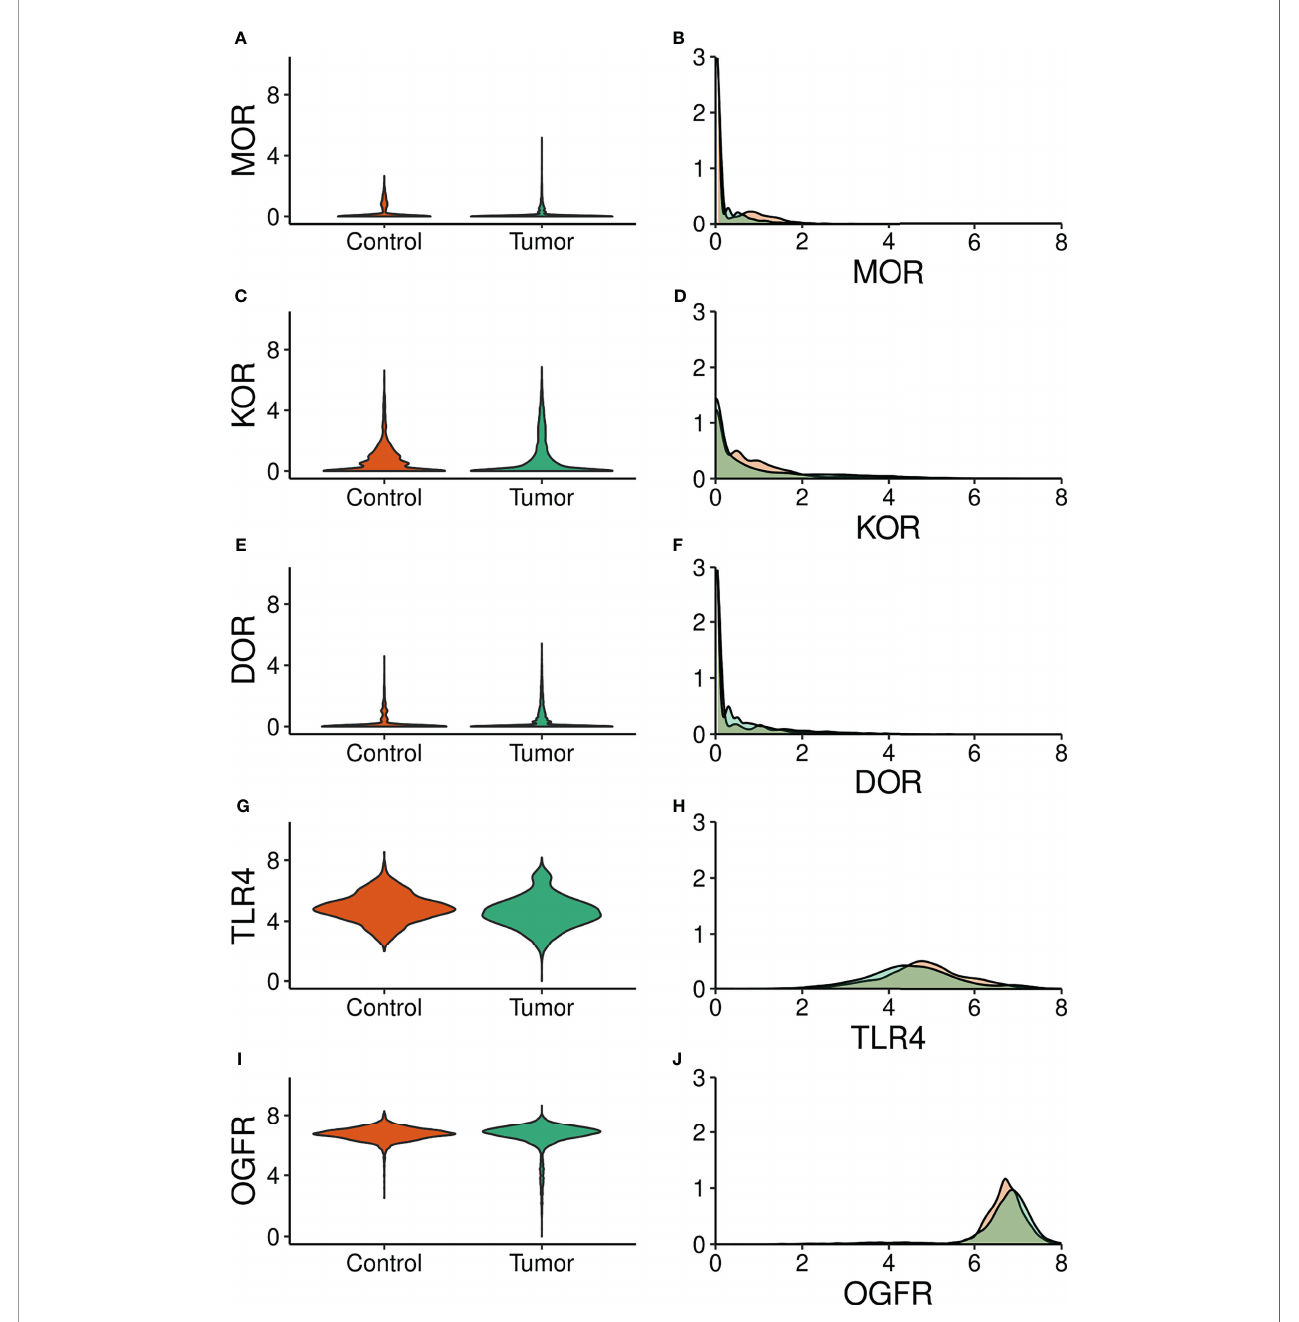
FIGURE 1 | Violin (Left panels) and density (Right panels) plots of the expression of opioid receptor genes. Green: tumor samples. Orange: control samples. MOR, µ opioid receptor; KOR, k opioid receptor; DOR, d opioid receptor; TLR4, toll – like receptor; OGFR, opioid growth factor receptor. (A, C, E, G, I) Gene expression (Log scale) is on the y axis. (B, D, F, H, J) Gene expression (Log scale) s on the x